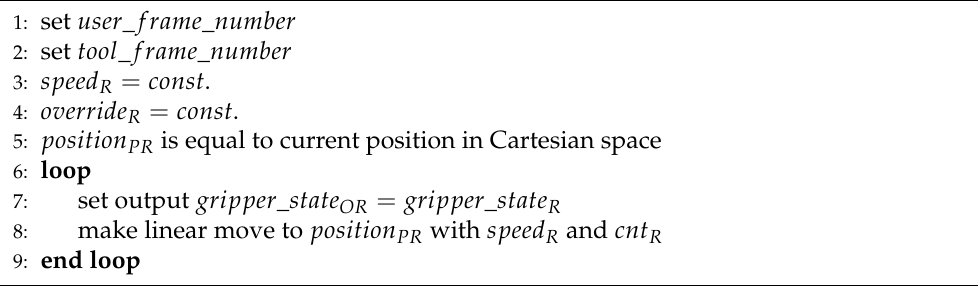
Algorithm 4 Collaborative robot: Register-based motion